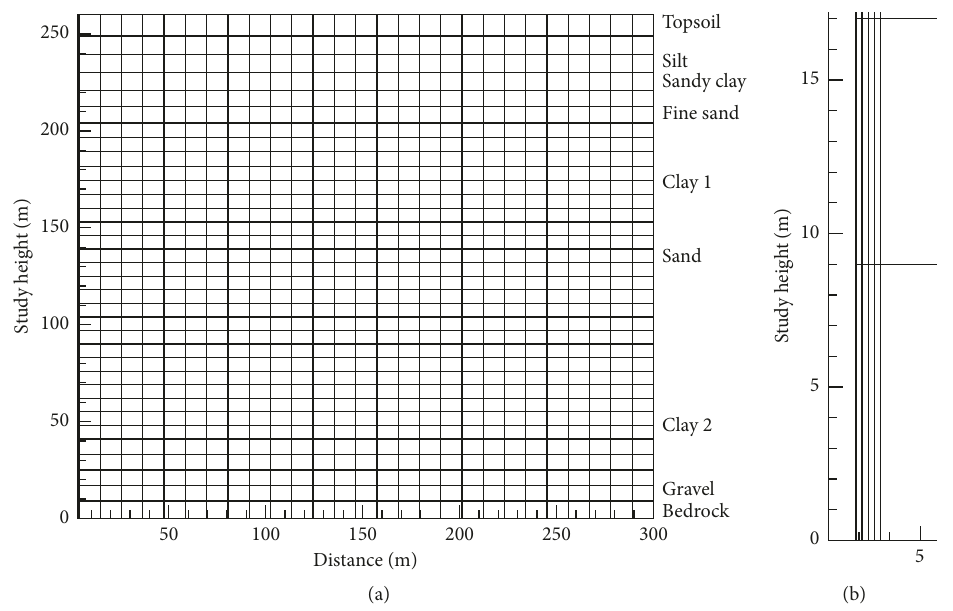
Figure 5: (a) Calculation model of the auxiliary shaft in the Zhuxianzhuang Coal Mine and (b) local enlargement of the shaft